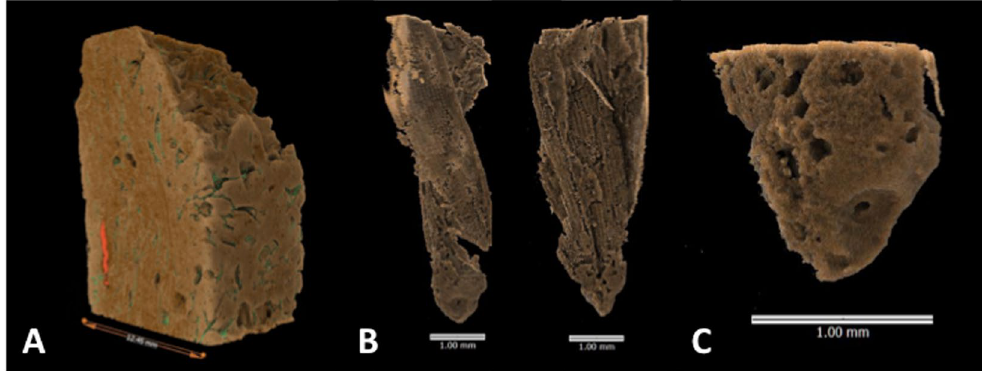
Figure 3. ( A ) – Tomograph of offcut from Sherd 5, Loc Giang, showing organic component in green and position of rice husk ( B ) and attached spikelet base ( C ) in red (Animation S6). ( B ) – Front and side view of tomograph of rice husk and attached spikelet base in offcut of Sherd 5. ( C ) – Closeup of tomograph of spikelet base in Sherd 5, showing irregular, and recessed, abscission scar at base of near complete husk, as well as evidence of rachis pore (Animation S7). Recessed nature of scar shows that force was used to remove seed husk from plant rather than naturally occurring wind dispersal.